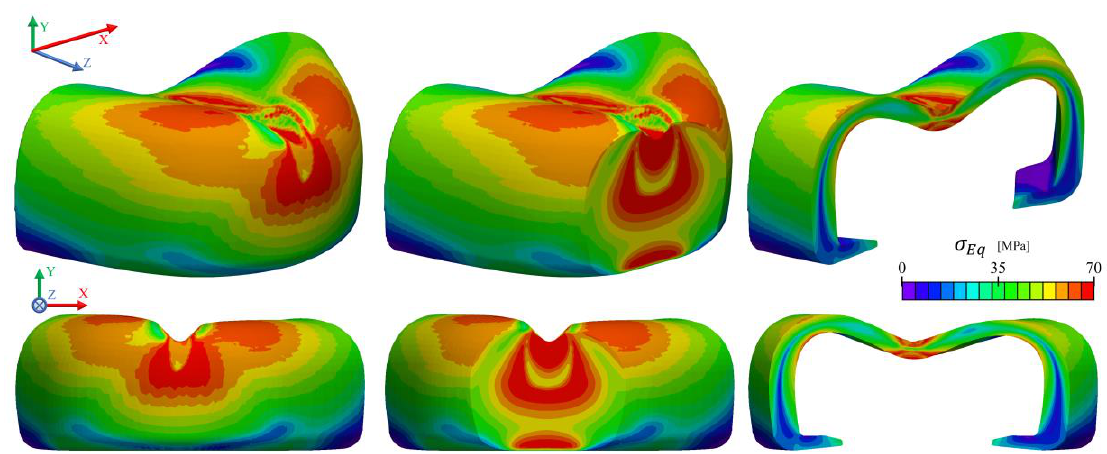
Figure 18. von Mises stress distribution on impact simulation of M4 toe cap